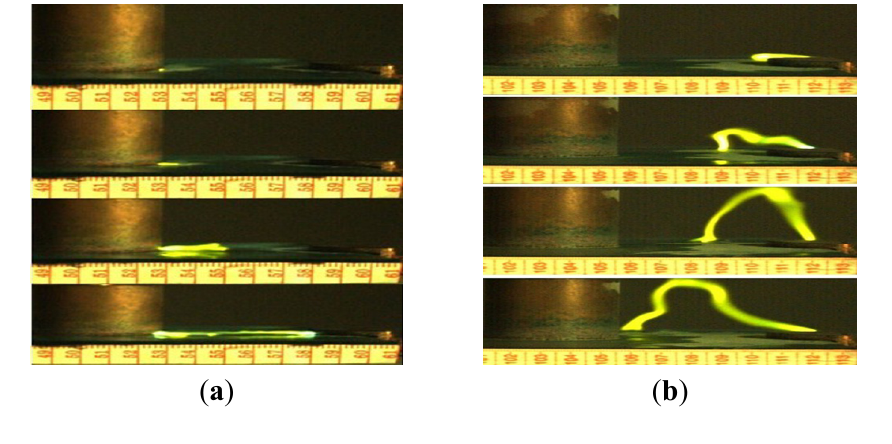
Figure 8. ( a ) Typical photos of development arc along the polluted surface with ESDD of 0.05 mg/cm 2 ; ( b ) Typical photos of development arc along the polluted surface with ESDD of 0.2 mg/cm 2